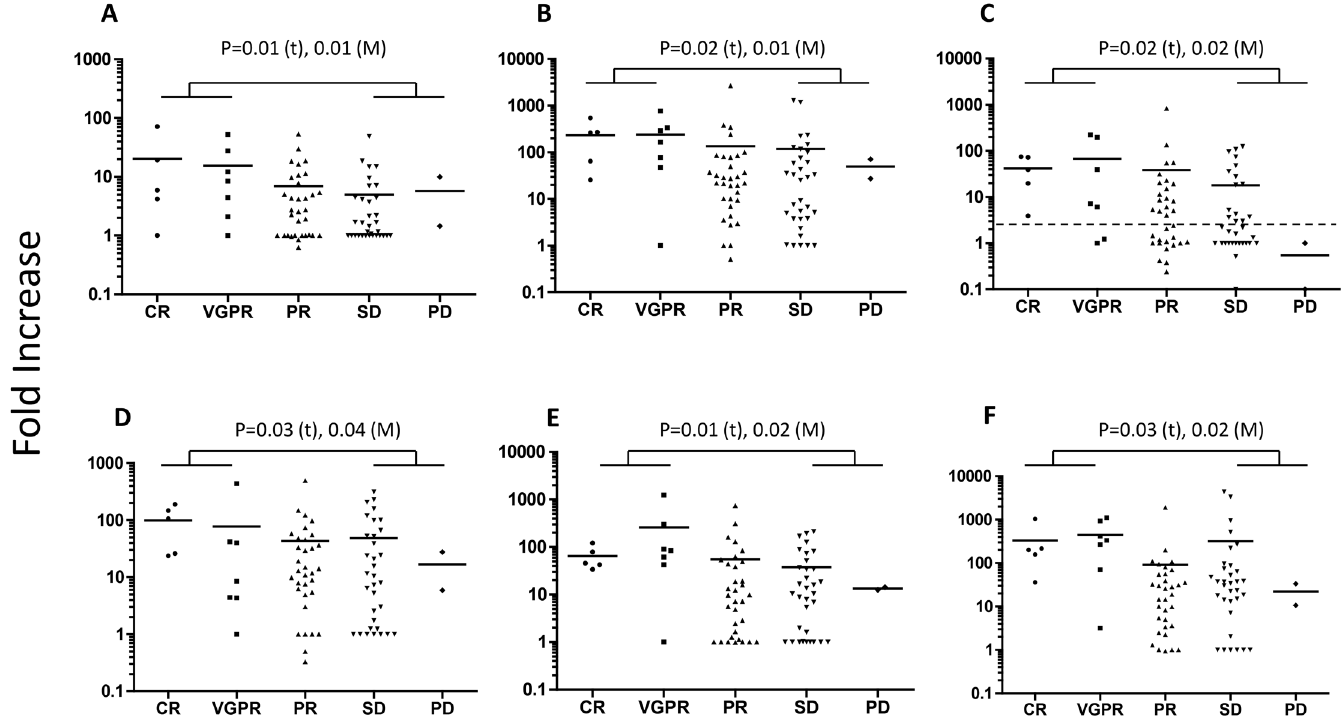
Fig 1. Ex vivo mRNA induction in blood obtained prior to bortezomib treatment. The fold increase in (A) LPS-induced GMCSF , (B) ZA-induced GMCSF , (C) LPS-induced CXCL10 (top panel), (D) PHA-induced CCL4 , (E) LPS-induced CCL4 and (F) ZA-induced CCL4 (lower panel) mRNA in the CR, VGPR, PR, SD and PD groups is shown. The statistically significant difference between the CR+VGPR and SD+PD groups is shown. t: Student ’ s t -test, M: Mann- Whitney test. Dotted line: fold increase = 3. Samples showing a fold increase in ACTB (which was > 3) were removed from the analysis. Horizontal bars: the mean